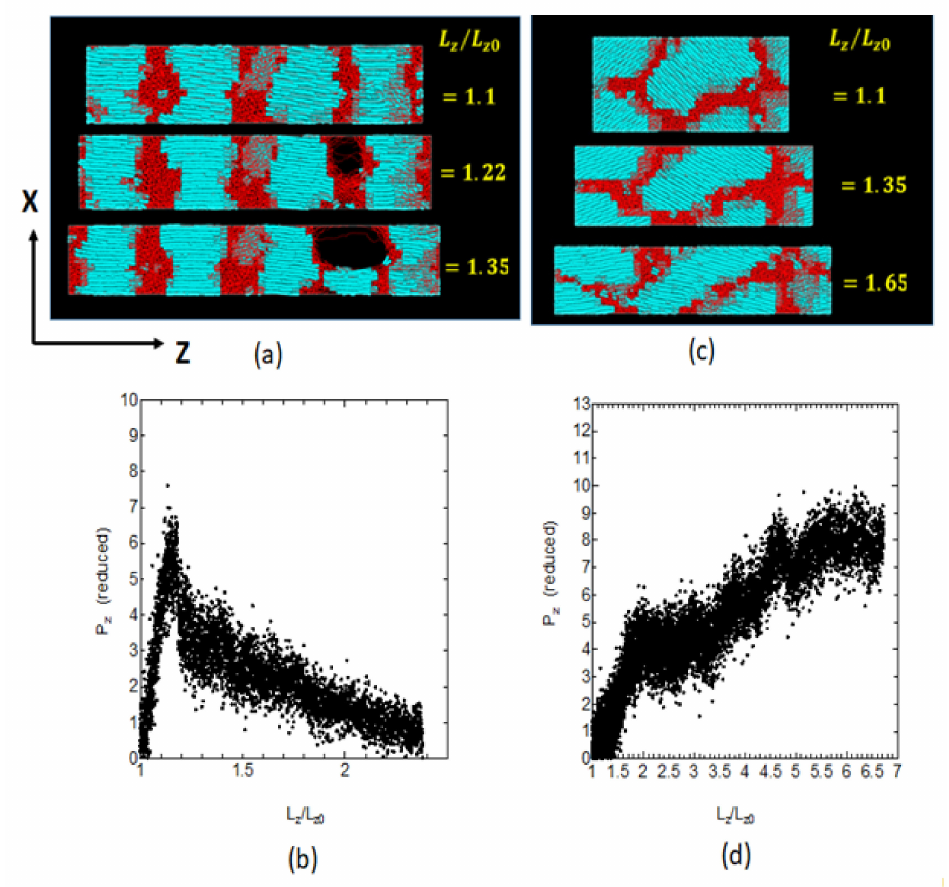
Figure 7. Typical fast deformation processes, with Hencky-strain rate 0.1/ns, during the uniaxial elongation along the Z -axis; ( a ) and ( b ) are for the well-developed textures obtained for t hold = 1 ns (State A in Figure 5a), and ( c ) and ( d ) are those for t hold = 4 ns (State B in Figure 5a). The snapshots ( a ) and ( c ) indicate the morphological changes for the indicated degree of deformation L z / L z 0 , while the graphs ( b ) and ( d ) are the stress–strain curves for the corresponding deformation; L z and L z 0 indicate the sample length along the direction Z and that of the initial state, respectively. The blue and red regions correspond to the crystalline and amorphous regions,